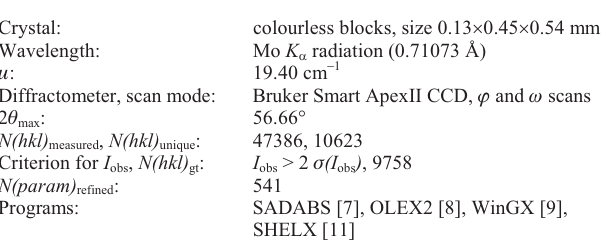
Table 1. Data collection and handling.